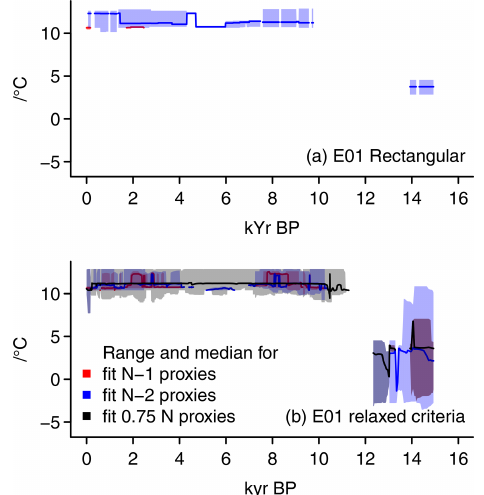
Figure 12. Visualizing alternative reconstructions: (a) E01 with rectangular tolerance range, (b) E01 with relaxed criteria for ana- logue selection. Panel (a) includes the median and the full range for the reconstructions under a 99% tolerance envelope (red) and a 99.99% envelope (blue). Panel (b) shows range and median for setups where the analogue candidates are valid even if they fail at one (red) or two (blue) locations or at 25% of all locations